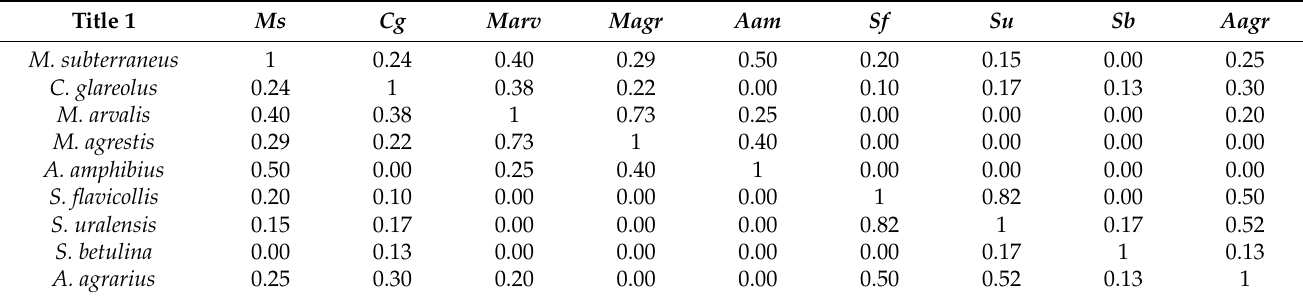
Table 3. Similarity of helminth fauna in myomorph rodents from the National park “Smolny” (C m